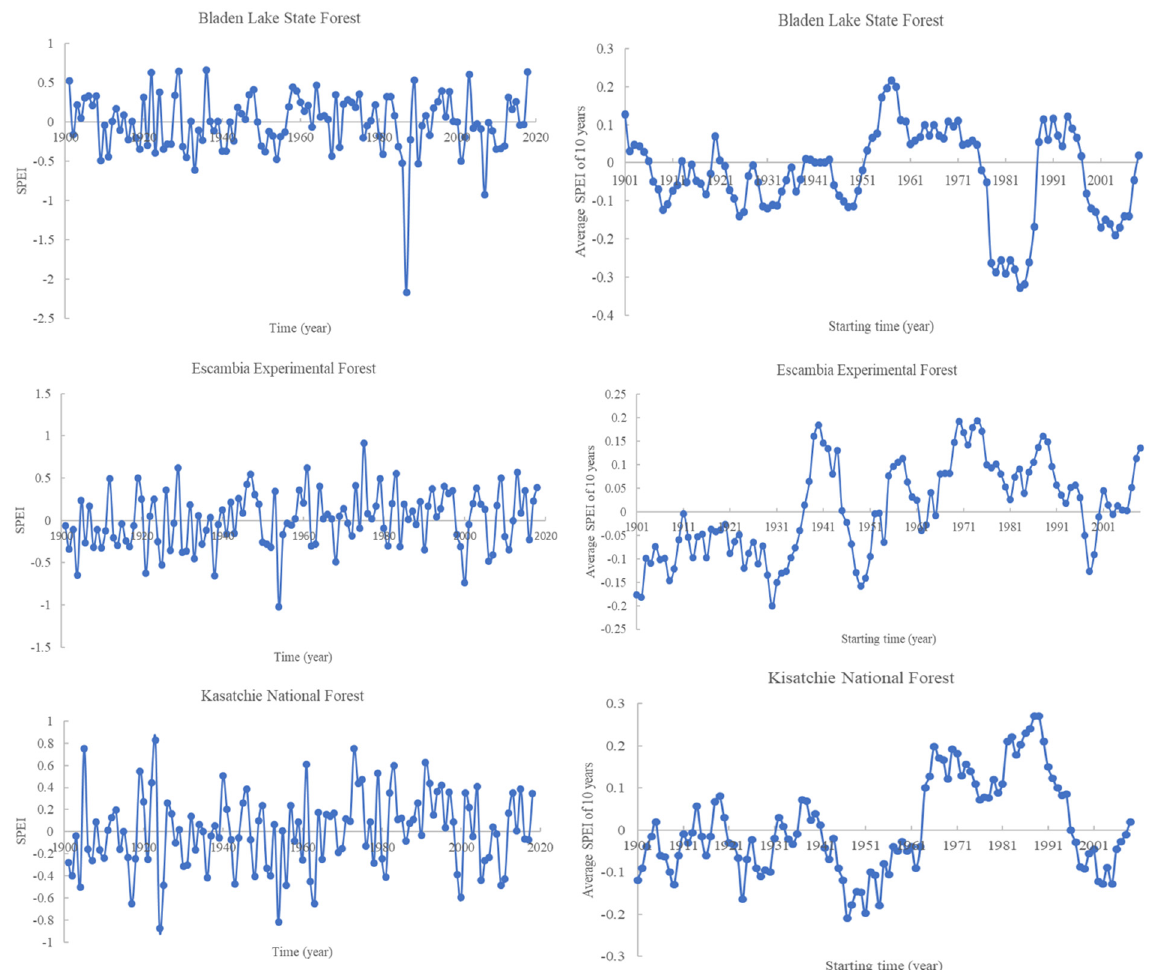
Figure 8. The dynamics of annual SPEI and the average of every 10 years at the 3 sites from 1901 to 2018.